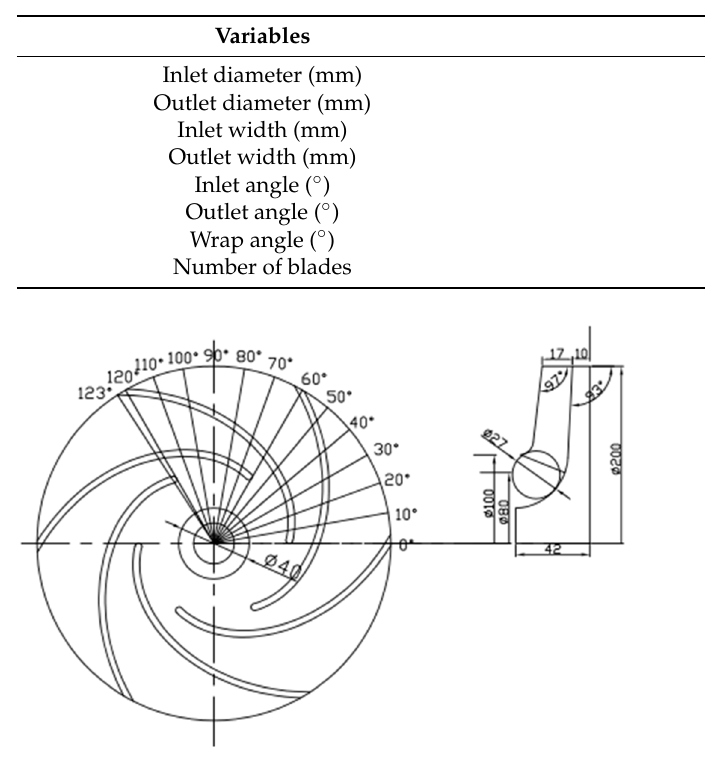
Table 1. Main parameters of the original impeller.